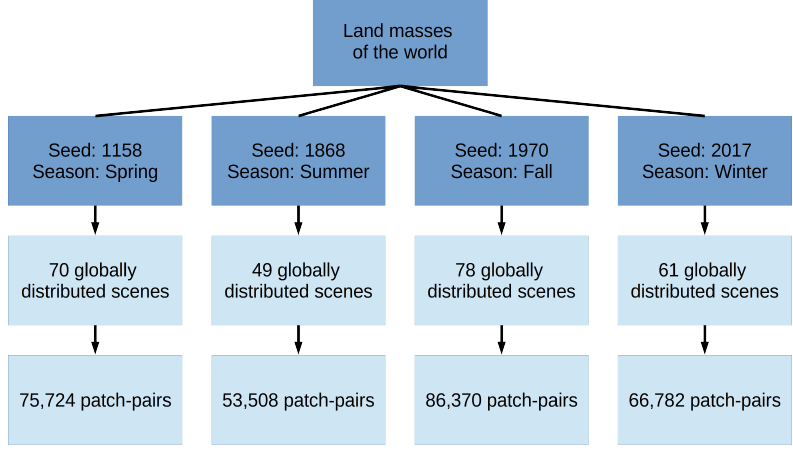
Figure 3. Structure of the final dataset.